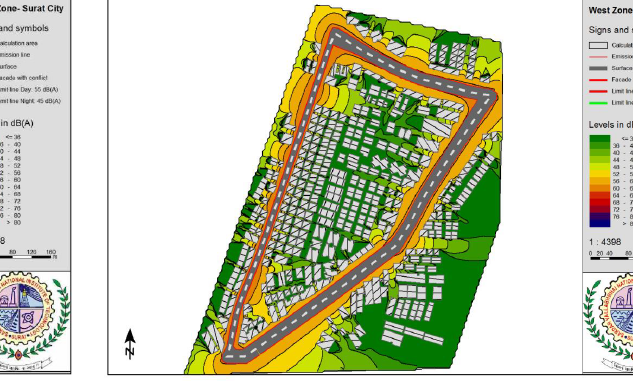
Figure 11: Night-time noise map of West zone using CORTN: